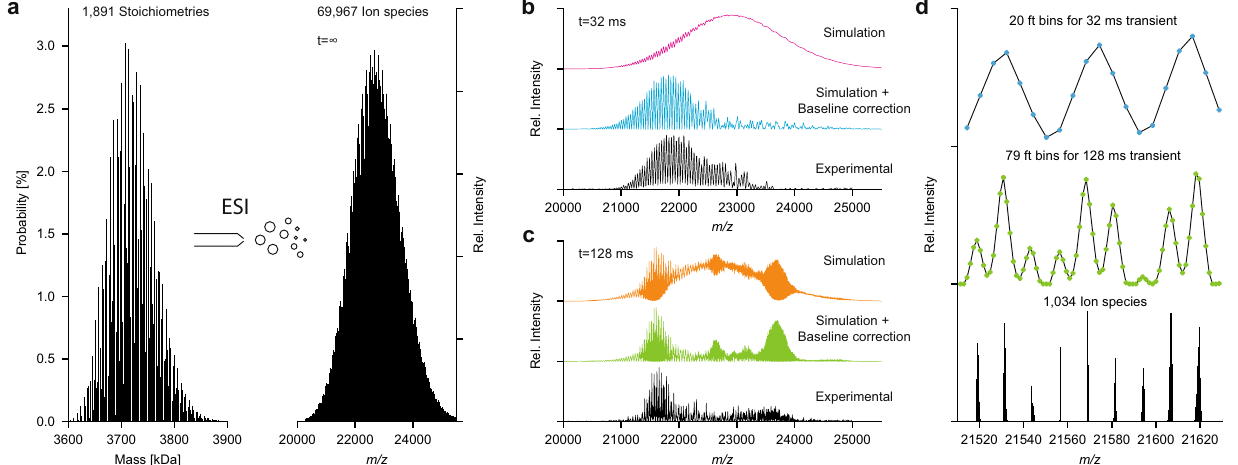
Fig. 4 ESI and native MS of complex AAV samples. a Theoretical mass distribution for all possible capsid stoichiometries of AAV9 and the resulting theoretical mass spectrum at in fi nite resolution. The mass distribution shows the 1,891 possible capsid masses with their probability as calculated in Fig. 2b. After ESI, each mass is simulated with 37 charge states yielding a total of 69,967 different ion species. b , c Simulated mass spectra for AAV9, showing the convoluted ion signals of the 69,967 different ion species shown in a) at resolutions, corresponding to transient times of 32 ms and 128 ms. Each plot shows (top to bottom) the simulated mass spectra before and after baseline correction with their experimental counterpart. Experimental data was recorded by transient averaging, thereby removing the unresolved regions presented in the non-baseline corrected. d Comparison (top to bottom) between 32 ms and 128 ms mass spectra and simulation at in fi nite resolution (data points/FT bins are shown as experimental and simulated spectra, are shown in Fig. 5 for several different empty AAV capsids from different serotypes and different production platforms; AAV1 VP3-only, AAV1, AAV5, AAV8, and AAV9. All tested serotypes show the same pattern in the native mass spectra, indicating that the stochastic assembly model applies broadly to all tested AAV serotypes.